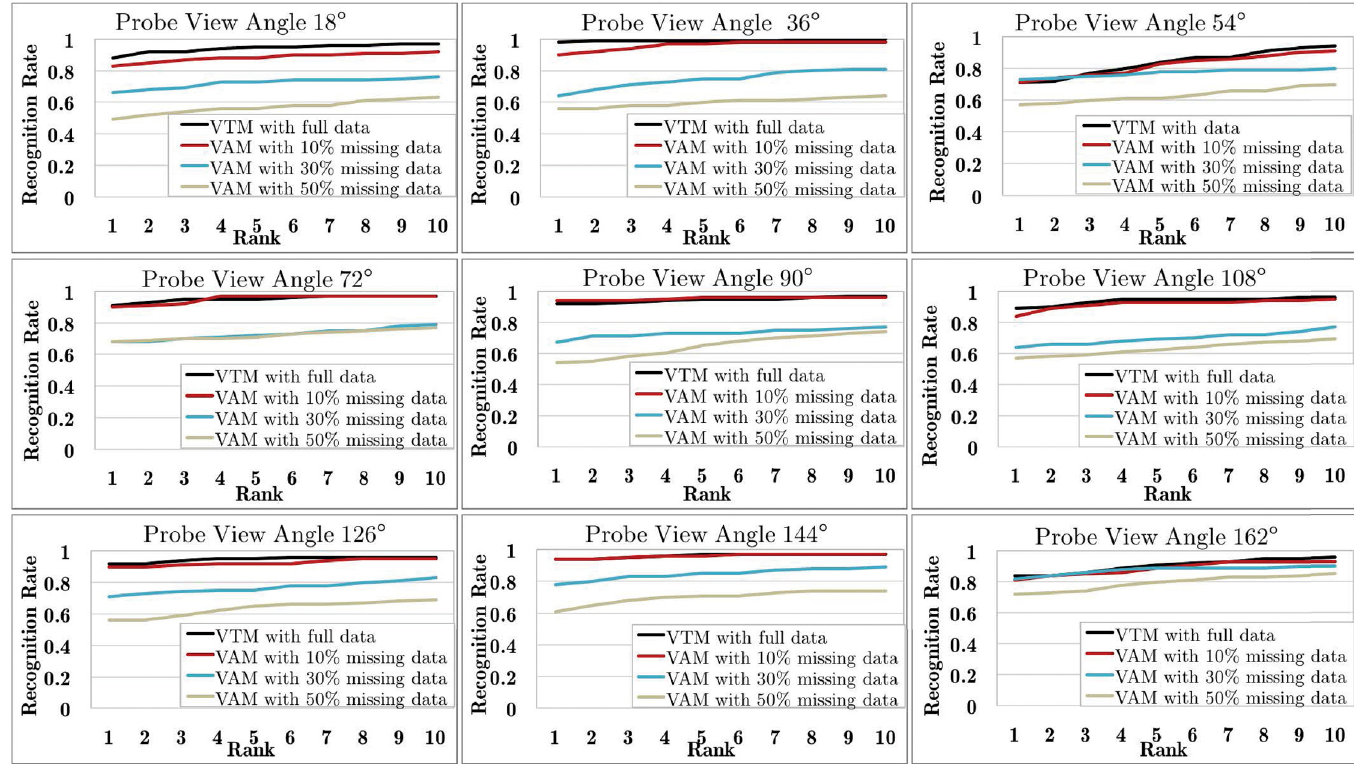
Fig 9. Results of free-view gait recognition in the data missing variant of CASIA-B, where different proportions of the training and gallery data were randomly abandoned.